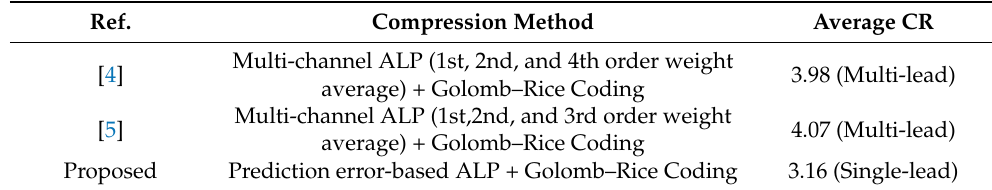
Table 1. The comparison of the average compression ratio to other methods on PTBDB data set. Ref.